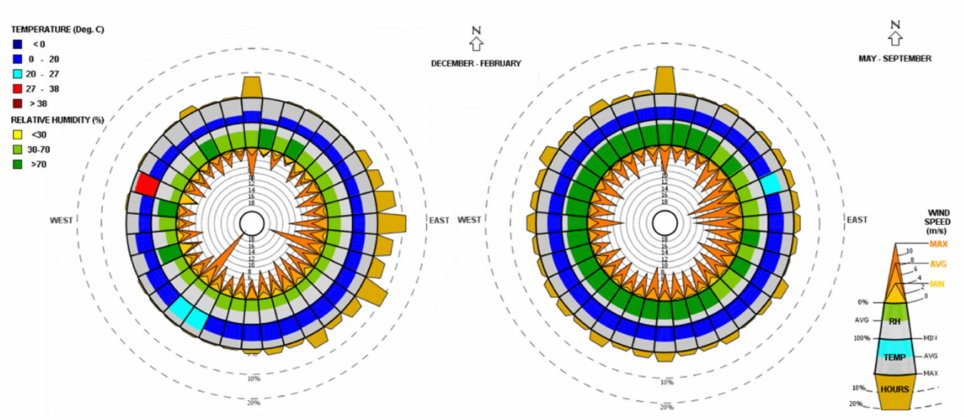
Figure 13. Prevailing winds in winter and summer, Addis Ababa, Ethiopia.